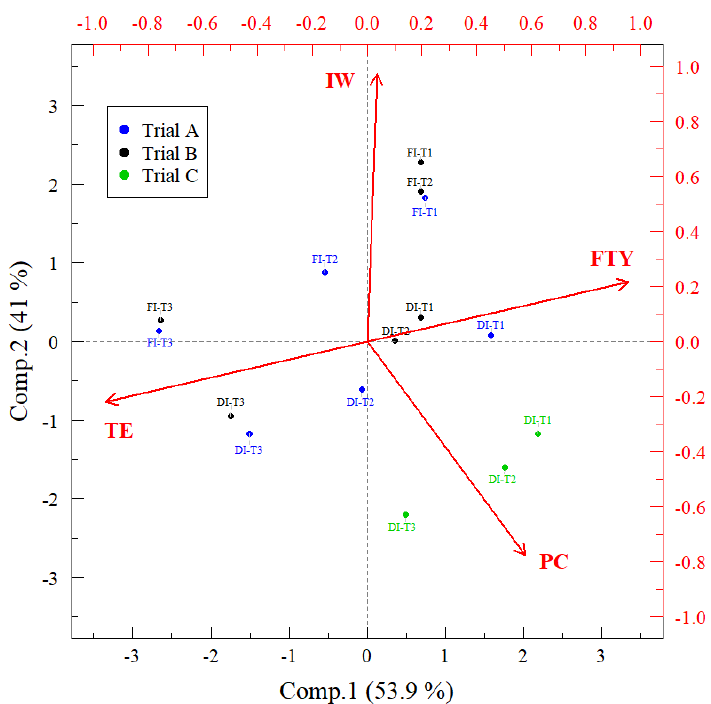
Figure 2. Drip (DI) and furrow (FI) irrigation under control (T1), 0.4 (T2) and 0.6 (T3) thresholds of crop water stress index (CWSI), with ordination based on principal component analysis for agronomic (DTY and IW), environmental (TE) and economic (PC) indicators. See abbreviations in Table